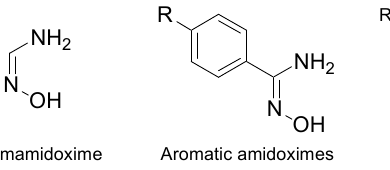
Figure 11. Some of the studied amidoximes and oximes for their activity in rat aorta relaxation.